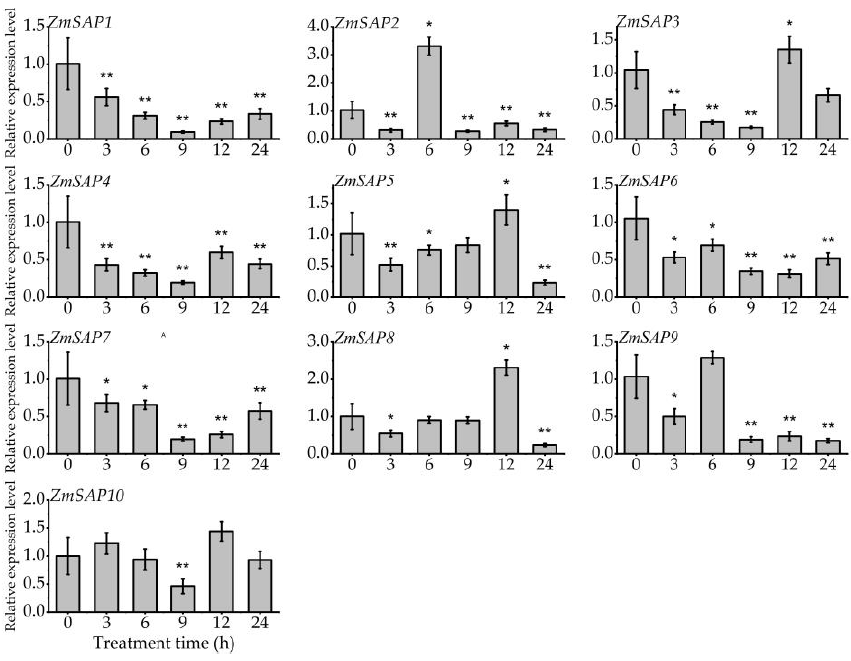
Figure 6. The expression of ZmSAP s under drought stress mimicked by 16% PEG-6000 treatment. * and **, indicates significant differences at p < 0.05 and p < 0.01, respectively.